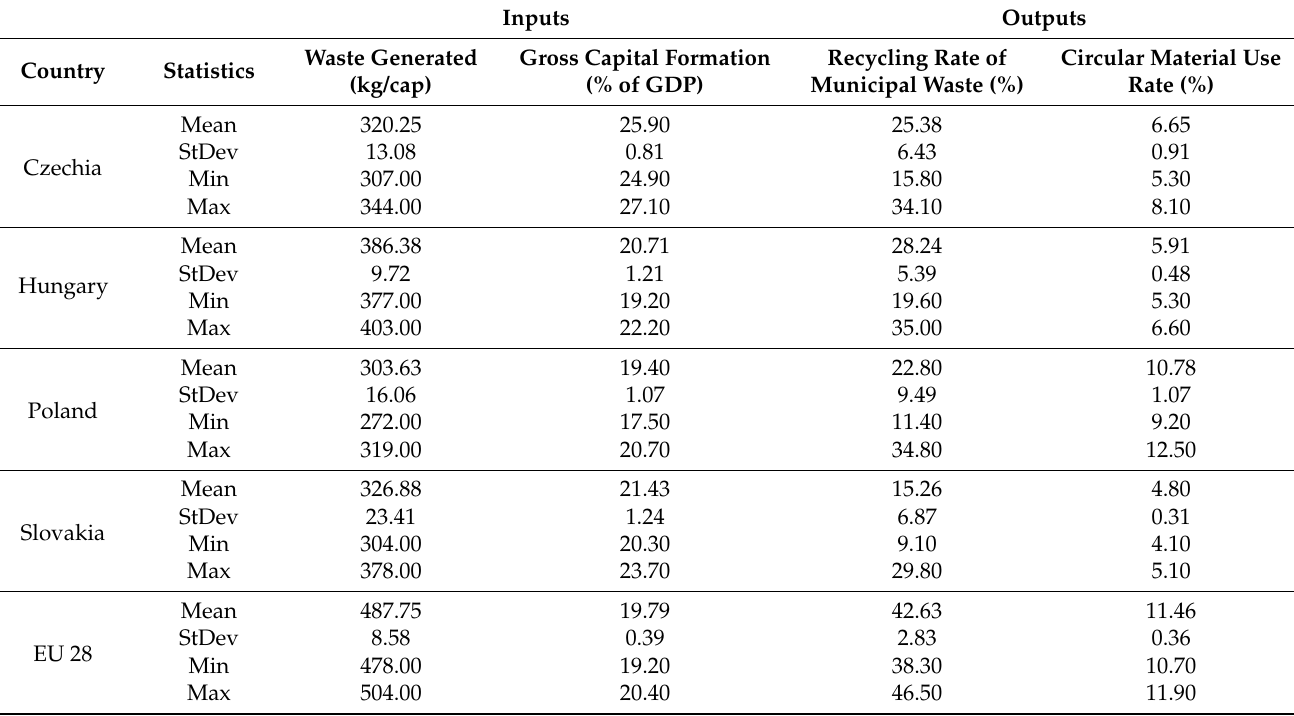
Table 1. Descriptive statistics of inputs and outputs of DEA